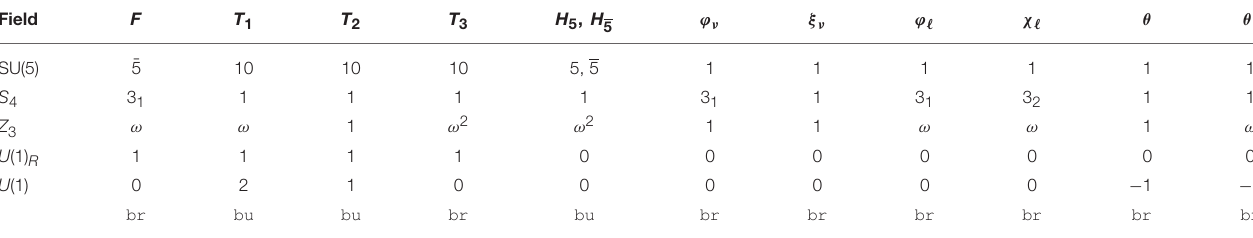
TABLE 5 | Matter and Higgs assignment of the model.